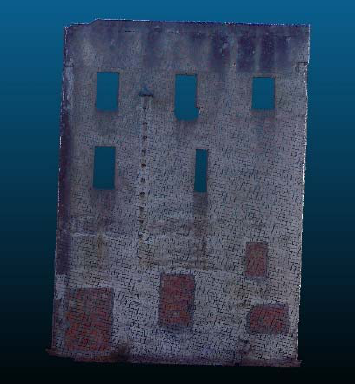
Figure 6: TLS point cloud.